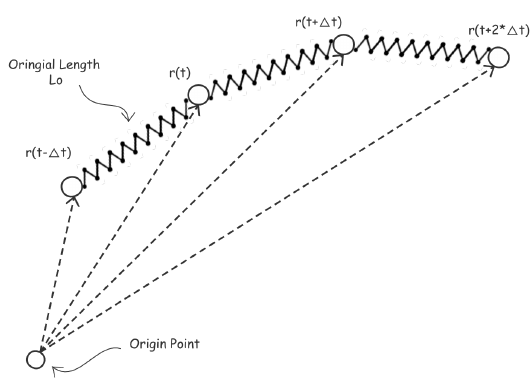
Figure 5. Classic Elastic